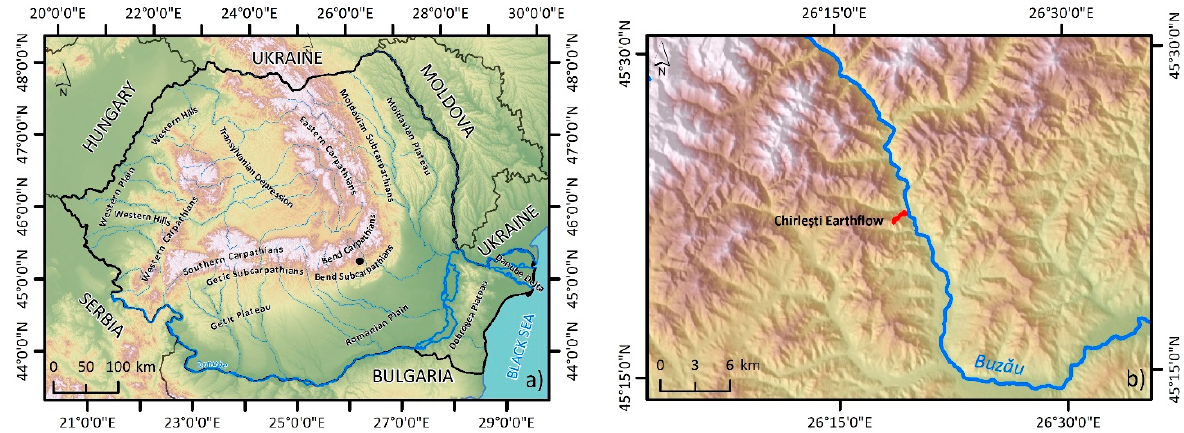
Figure 1. Location of Chirle ș ti earth fl ow within Romania ( a ) and Bend Subcarpathians ( b ). The disposition and array of the tectonic units are evident due to the alternation of a large variety of fl ysches with di ff erent lithology and cohesion, which display an alterna- tion of hard and soft strips. The elevation in the mountains from the Buz ă u watershed usually does not exceed 1500 m; however, the area near Chirle ș ti has a relatively low alti- tude, between 400 and 800 m.